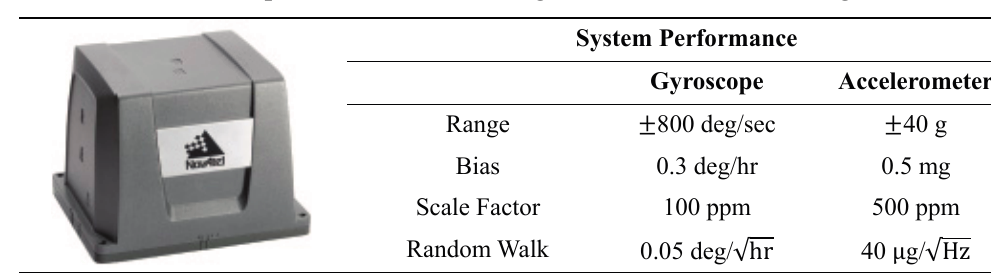
Table 1. Specifications for testing the tactical inertial